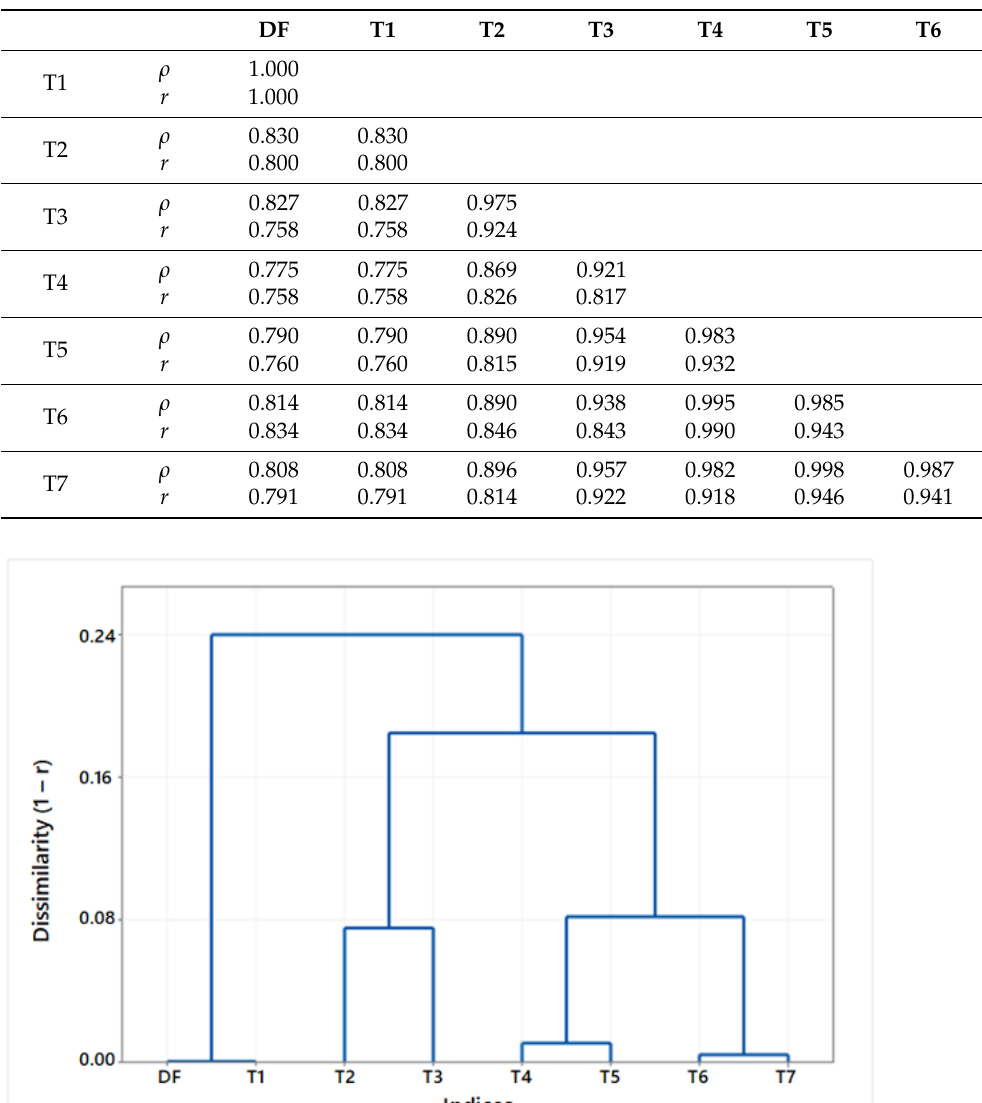
Table 7. Spearman rank correlation ( 𝜌 ) and Pearson correlation ( 𝑟 ) coefficients computed for pairs of the tortuosity indices.